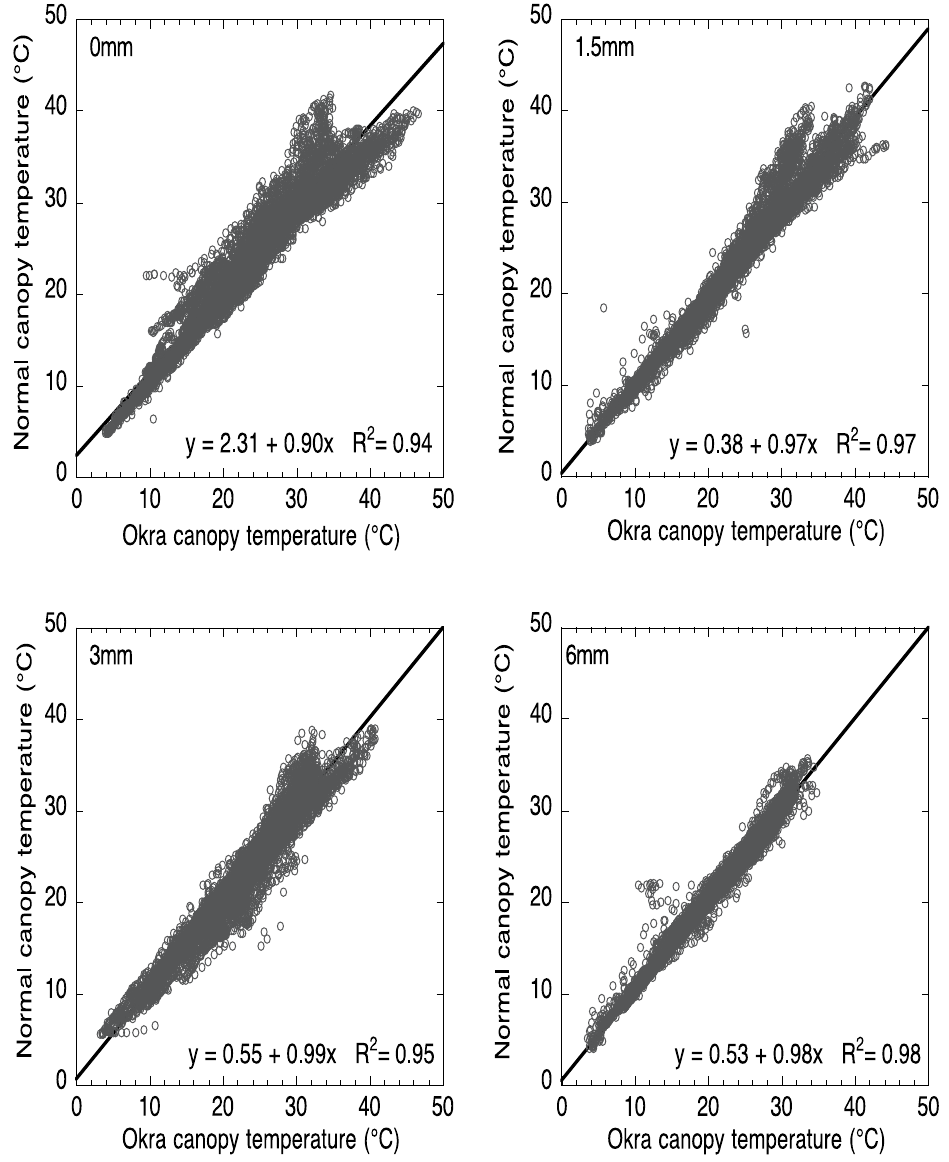
Figure 3. Comparison of canopy temperature at four irrigation treatments; 0 mm, 1.5 mm, 3 mm, and 6 mm for okra and normal leaf varieties over the 120-day study period.